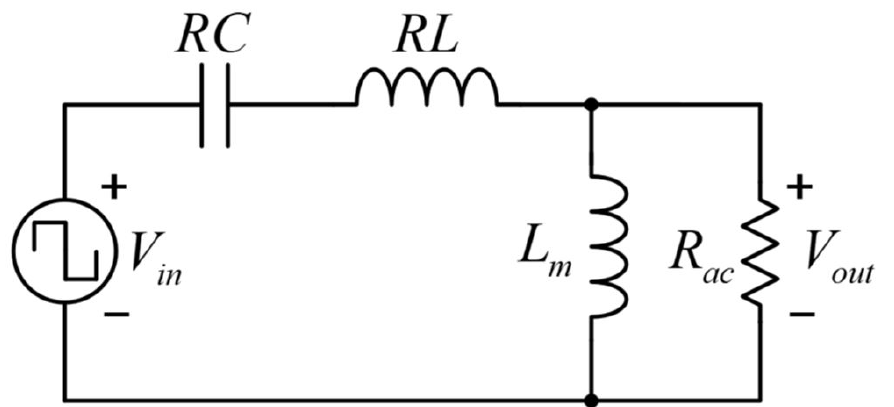
Figure 3. Equivalent circuit of an LLC resonant